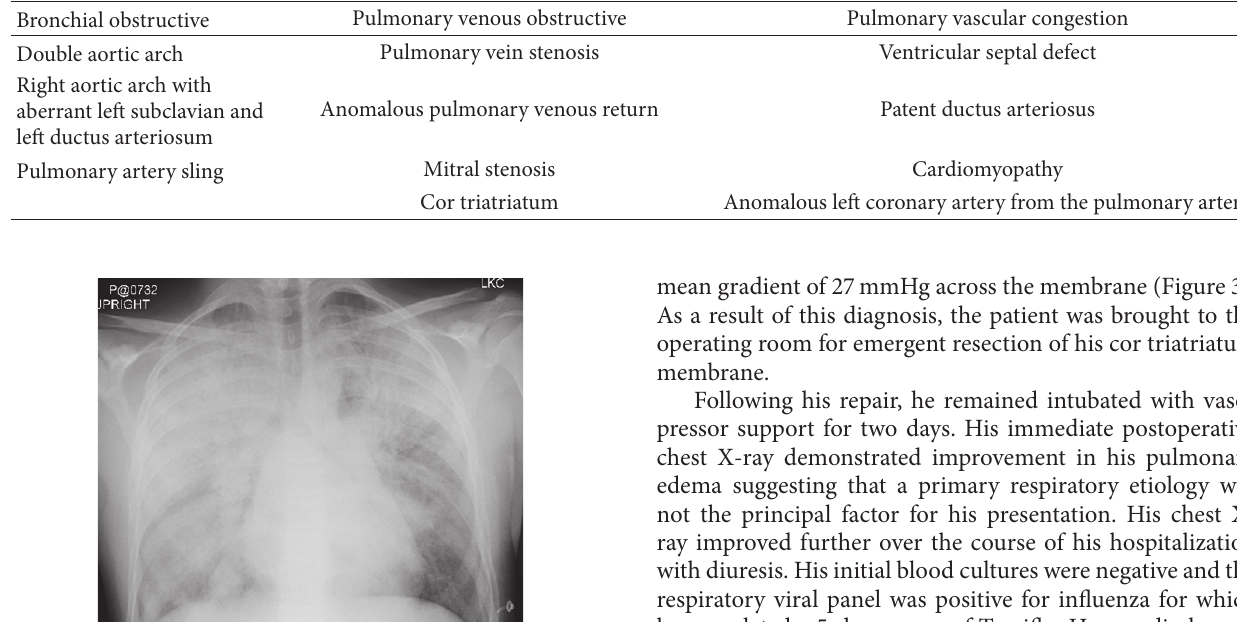
Table 1: Examples of cardiac causes of wheezing and respiratory distress.